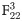
Ambiguity in logic-based GRN modeling.We consider the underlying Boolean function of a regulatory interaction as F223; i.e., f(A,B,C)=A¯BC+AB¯C+ABC¯. A: The set of the transitions in the SPSD of F223 starting from the initial state number 3 (Fig 5) can be observed in the SPSD of 15 other Boolean functions. All these functions are listed in the table. By taking the second step of the perturbation from the state number 2, the number of the Boolean functions having the common set of transitions is reduced to 4. The gray cells in the table are the remaining functions after taking the second step. B: The logic circuit of the functions listed in the table. C: The logic circuit of the remaining functions after the second step (corresponding to the gray cells in the table).